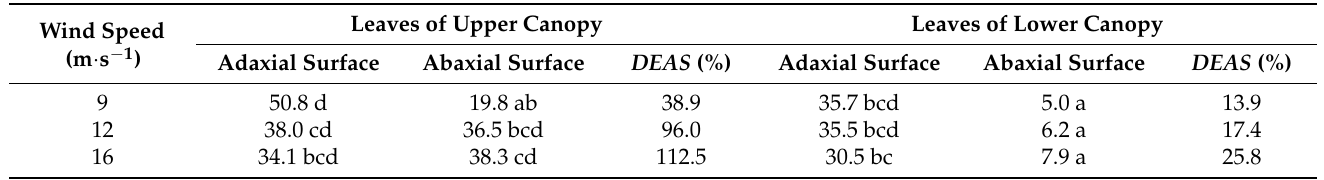
Table 6. Coverage (%) of the leaves and the DEAS values at different outlet wind speeds.